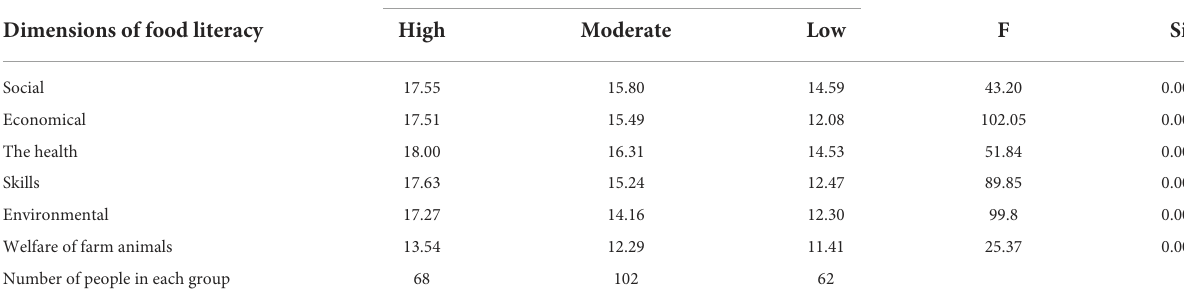
Food literacy rate